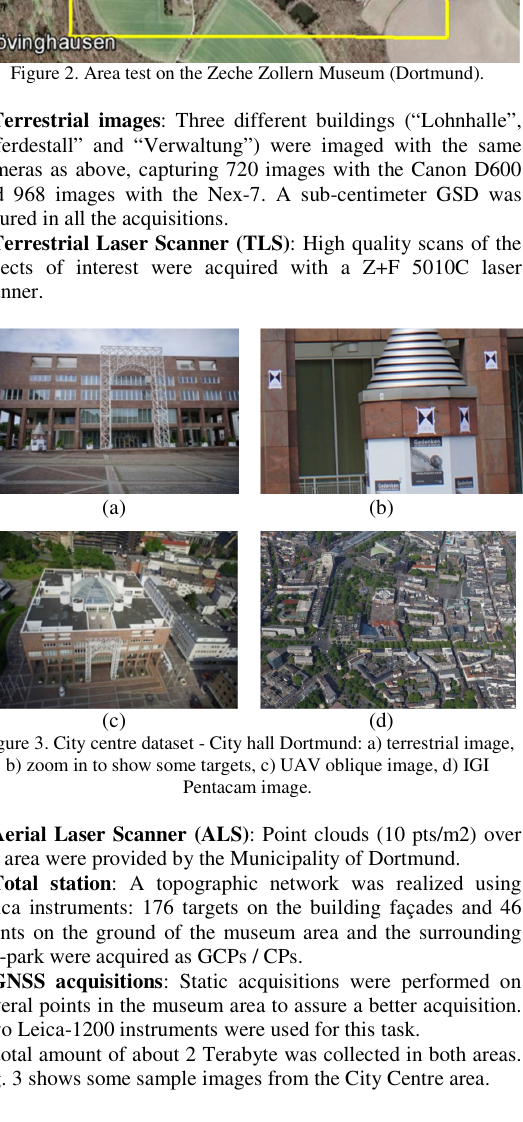
Figure 4. City hall Dortmund: a) TLS reference data (intensity color coded visualization) and b) ALS reference data (height color coded